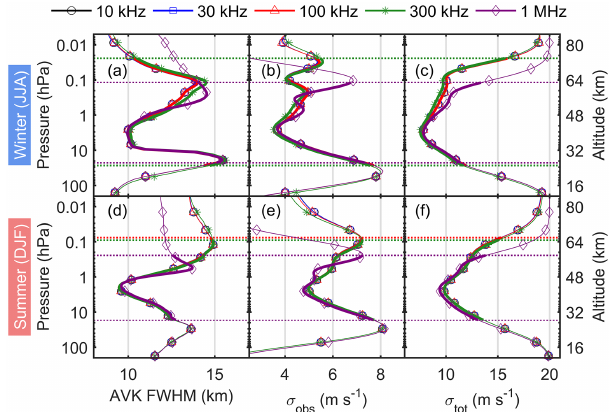
Figure 7. Zonal wind retrievals for different zenith viewing angles, where AVK FWHM are the full-width half-maxima of each aver- aging kernel, σ obs is the measurement uncertainty, and σ tot is the total uncertainty. Calculations are for simulated clear-sky, 12h ob- servations (i.e. 6h in east and 6h in west directions) of the O 3 231.28GHz line in mean winter (JJA) and summer (DJF) conditions at Halley station (75 ◦ 37 (cid:48) S, 26 ◦ 14 (cid:48) W), Antarctica using a ground- based radiometer with a 1400K system temperature and 30kHz fre- quency resolution. The horizontal dashed lines and thicker sections of the curves indicate the pressure/altitude ranges where MR ≥ 0.8.